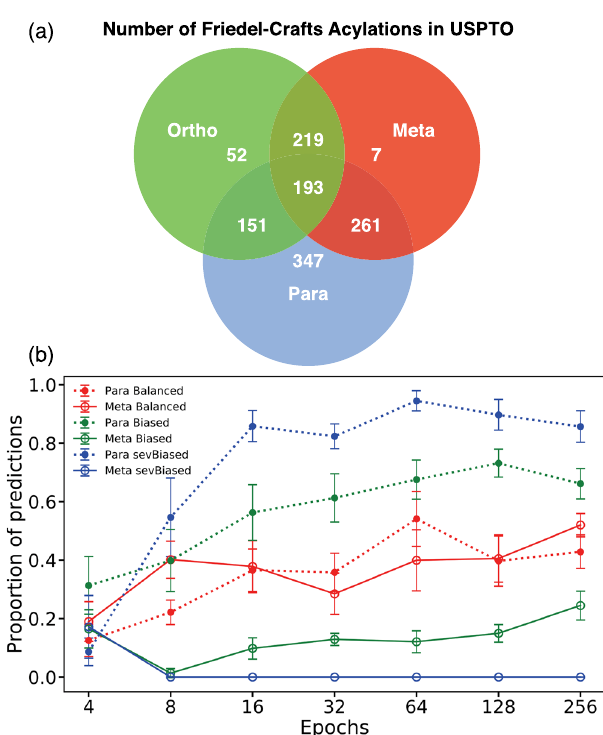
Fig. 5 The effect of biased training data on the predictions of the Molecular Transformer. a The number of para Friedel – Crafts acylation reactions far outweigh those of meta or ortho reactions. b Dataset bias is re fl ected in the model predictions. The fi gure shows the proportion of para (solid line) and meta (dashed line) predictions on a balanced test set as a function of the number of training epochs for different biased training sets. The error bars shown indicate the standard deviation in the results from training an ensemble of 10 randomly initialized models. The proportion of meta and para predictions does not always add up to 1, because it takes a number of iterations for the model to learn the SMILES syntax and we discount invalid